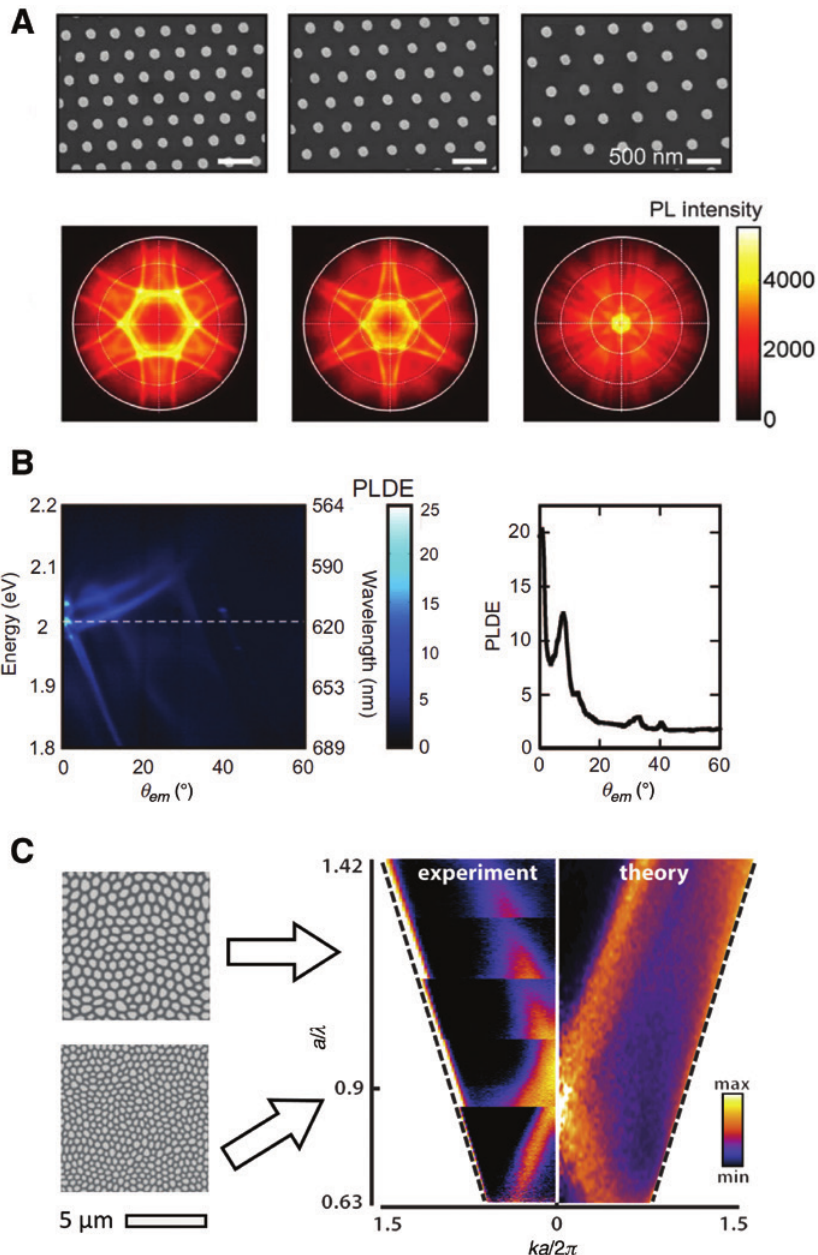
Figure 14: Diffractive outcoupling of emission by plasmonic metasurfaces. (A) Top row: SEM images of hexagonal Al nanoparticle arrays deposited on top of a 700-nm-thick dye-doped polymer layer. Periodicity of these arrays is 375, 425, and 475 nm, respectively. Bottom row: Fourier images of the emission collected from the corresponding samples in the top row. Republished with permission of the Royal Society of Chemistry (Great Britain), from [57]; permission conveyed through Copyright Clearance Center, Inc. (B) Emission properties of a layer of dye molecules on top of an array of Al antennas pumped by an incoherent blue LED source. On the left: photoluminescence directional enhancement (PLDE) spectra as a function of the emission angle θ . On the right: PLDE versus θ at a given emission wavelength (2.01 eV). Reprinted by permission of the Springer Nature, from: Light: em em Science and Applications, Plasmonics for solid-state lighting: enhanced excitation and directional emission of highly efficient light sources, Lozano et al. [77], Copyright 2013. (C) Emission properties of random assemblies of plasmonic nanoparticles of various sizes, shown in the SEM images on the left, covered by a 50-nm-thick layer of polymer (PMMA) doped with fluorescent dye (DCM). Experimental frequency- momentum maps of the emission for several different sizes are stacked together in order to show the dependence on the size-to-wavelength ratio, which is compared with calculations (on the right). Reprinted from [66], https://doi.org/10.1063/1.4983990, under the Creative Commons Attribution 4.0 International